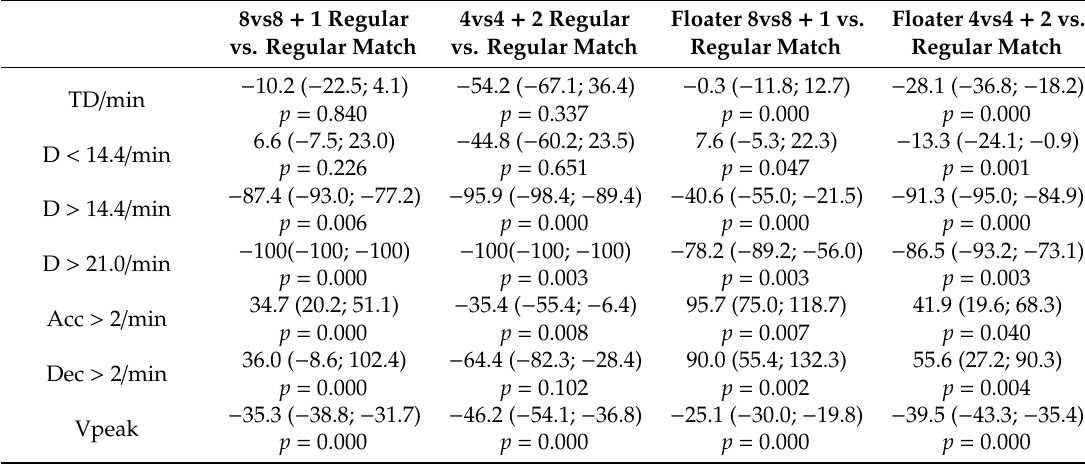
Table 5. Comparisons in the physical demands encountered by floater and regular players between the 8vs8 + 1 LSG and the 4vs4 + 2 SSG and the